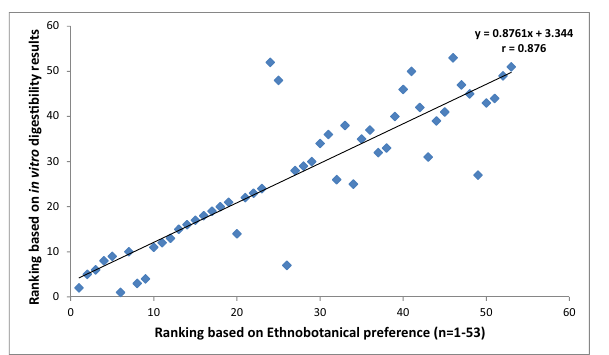
y = 0.8761x + 3.344 r = 0.876